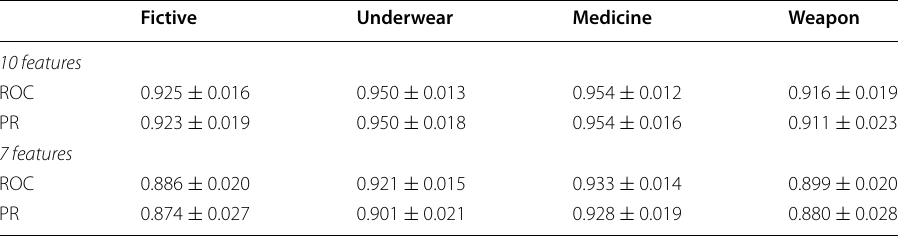
The average and standard deviation were calculated based on the 100 classifiers